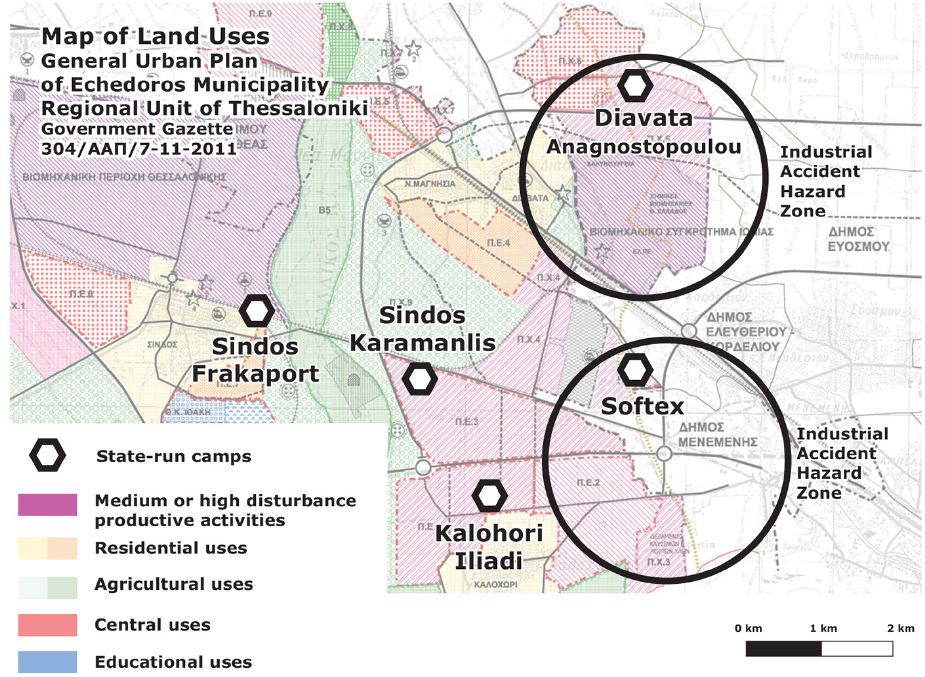
Figure 5. Map of land use in the municipality of Echedoros in the regional unit of Thessaloniki and positions of state-run refugee camps. Source: Authors, based on the land uses map of the General Urban Plan of Echedoros Municipality (Greek Government,